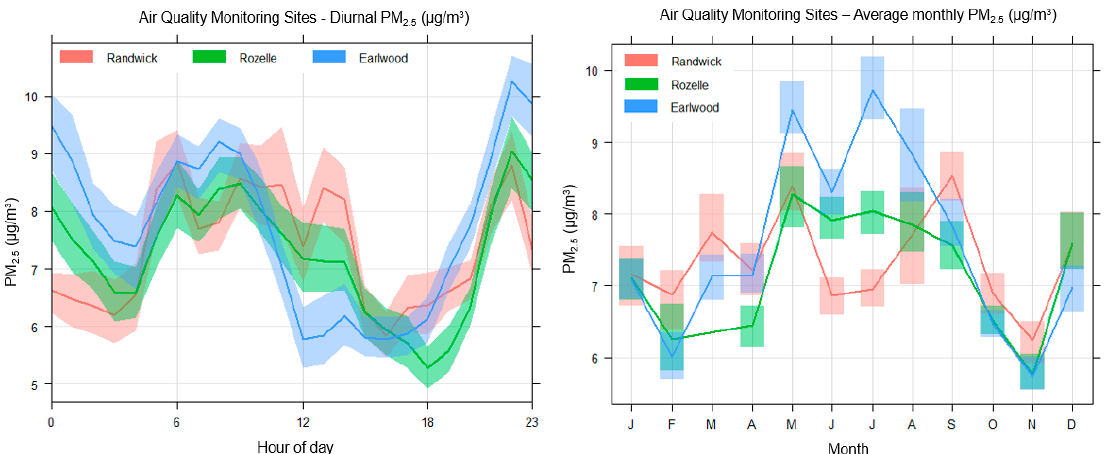
Figure 7. Comparison of PM 2.5 data at Randwick, Rozelle, and Earlwood Air Quality Monitoring stations (1 / 04 / 2017–30 / 11 / 2018). ( Left ): Diurnal variation of PM 2.5 and ( right ): monthly variation of PM 2.5 at each station. Shading corresponds to the 95% confidence interval with respect to the mean.